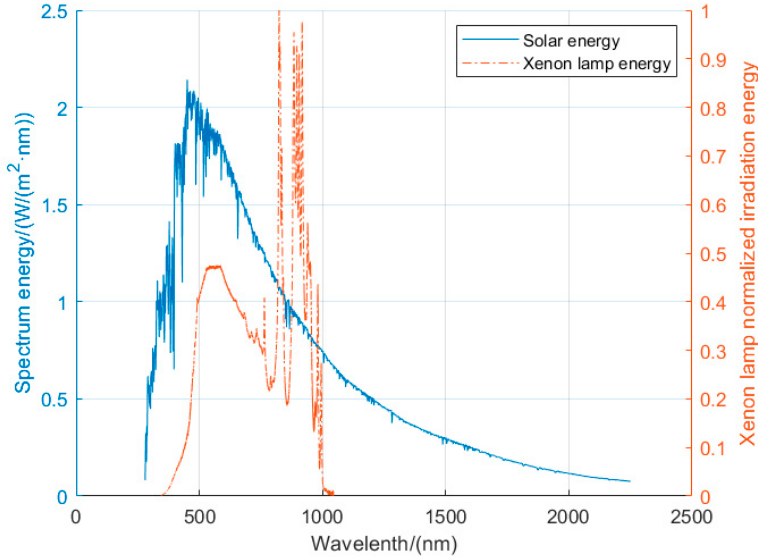
Figure 9. Solar [24] and xenon lamp spectrum energy distribution.